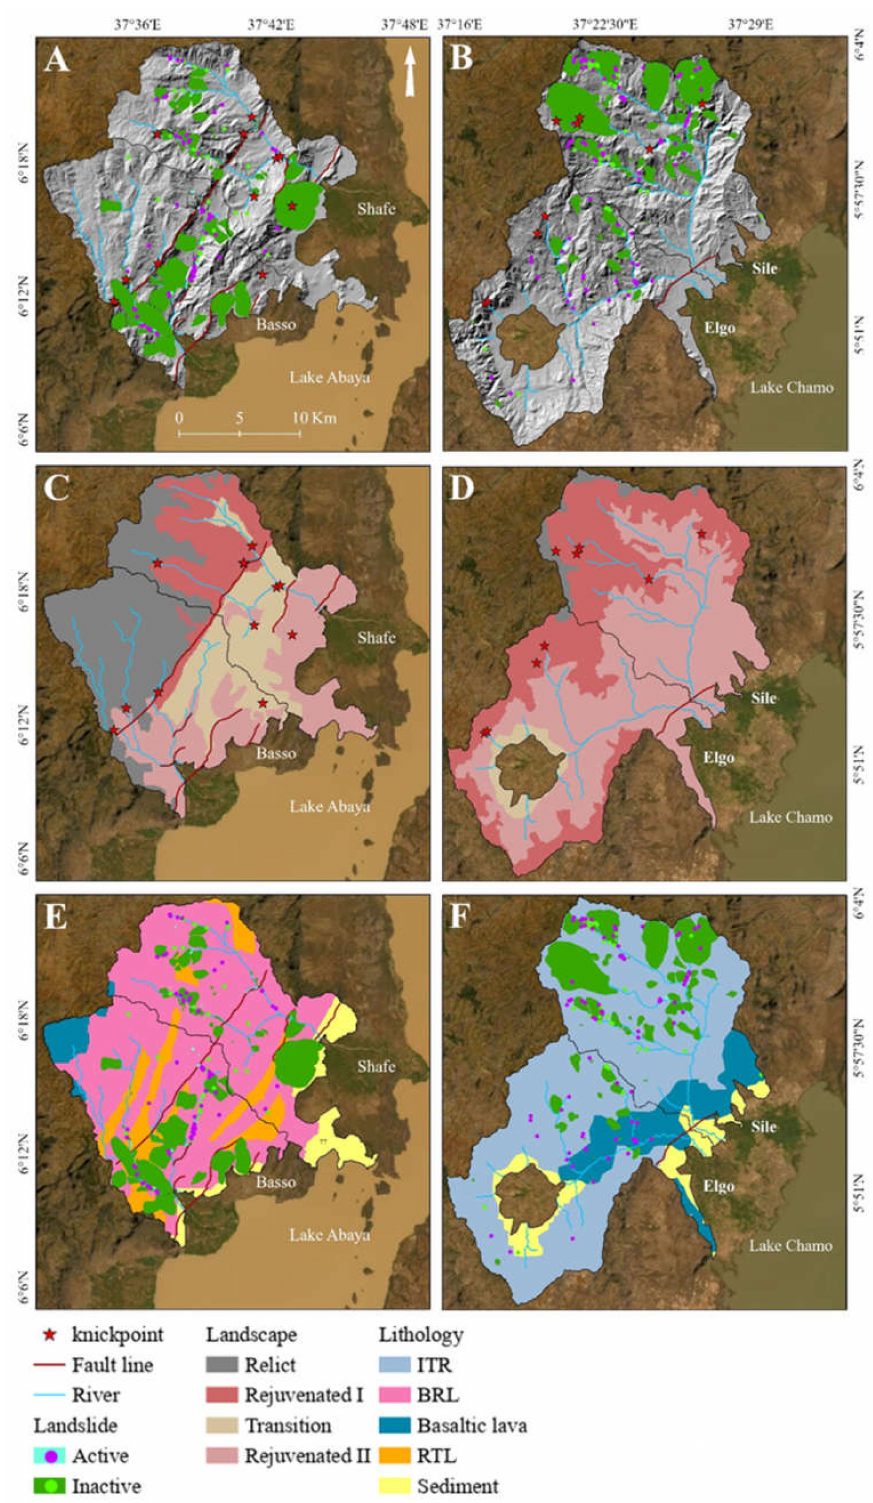
Figure 3. Landslide inventory classified by the level of activity ( A , B ), landscape rejuvenation ( C , D ), and lithology ( E , F ). Landslides <0.014 km 2 are represented as dots for visibility on maps. In Shafe and Basso, >70% of the area is basaltic and rhyolitic lava flows (BRL), and ~10% is rhyolites and trachytic lava (RTL). In Sile and Elgo, more than two thirds of the area is dominated by ignimbrite of trachytic to rhyolitic (ITR) composition. The hillshade is from the 30 m SRTM DEM [68]. Background imagery is from Google Earth (15 June